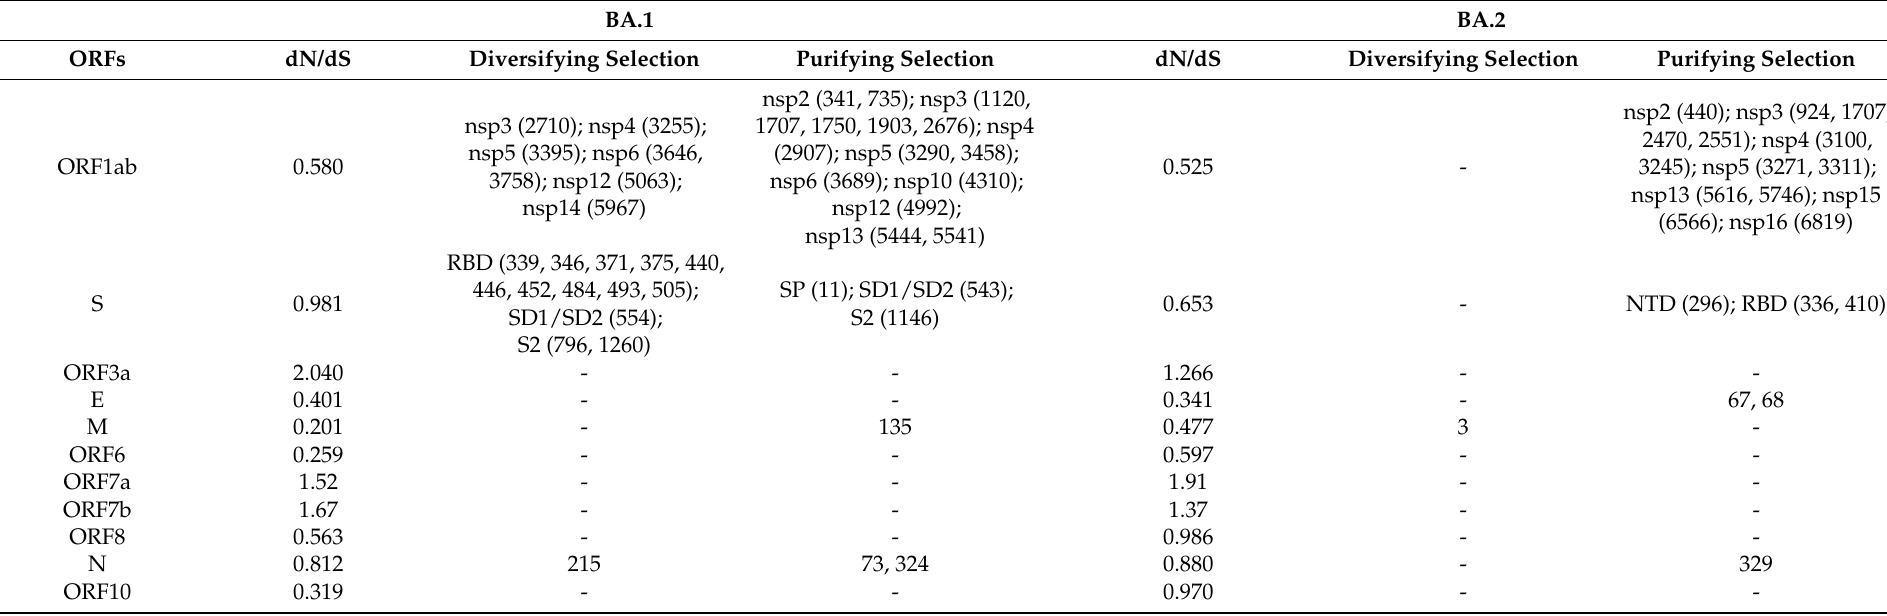
Table 1. Amino acid sites under diversifying or purifying selection for each protein-encoded region of the Omicron BA.1 and BA.2 sub-lineages. BA.1